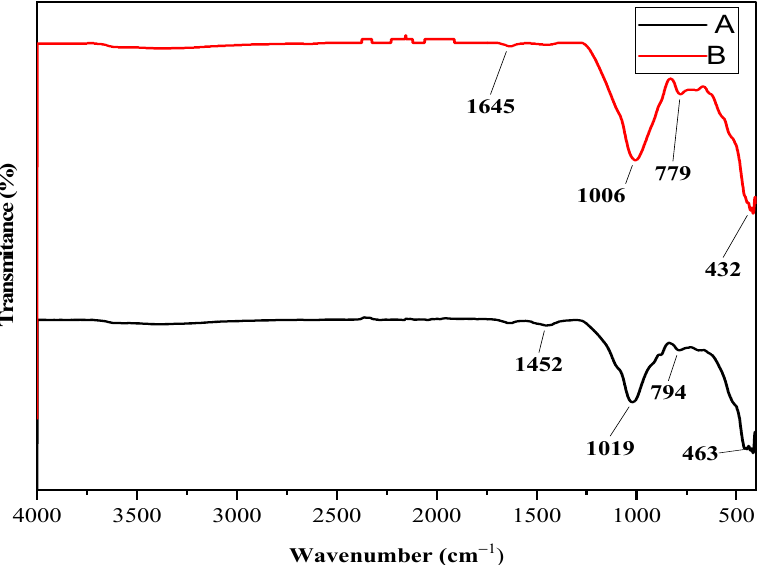
Figure 3. TMS Fourier-transform infrared (FTIR) (A) before adsorption and (B) after